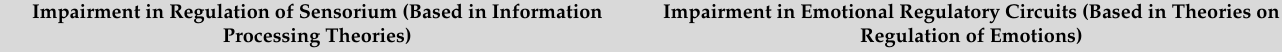
Table 1. Psychological Constructs, Behavioral Categories emanating from them and individual symptoms collected herein, under each Behavioral Category. This is an adaptation of the LuBAIR™ Inventory. Available on line: http://www.dementiabehaviors.com (accessed on 11 December